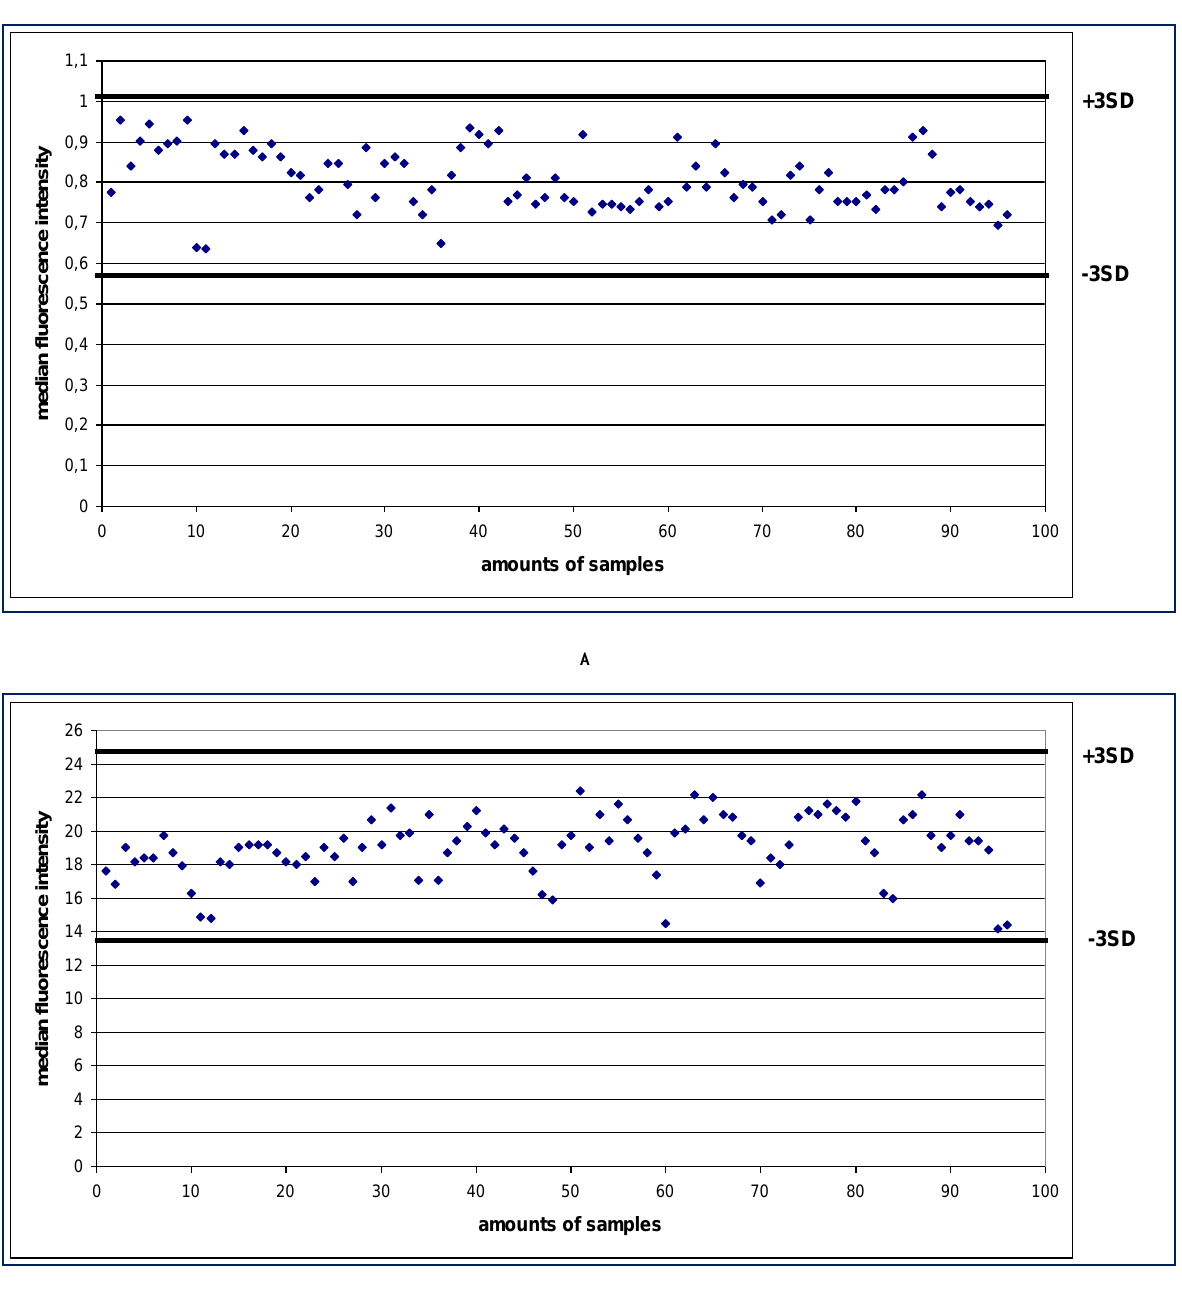
FIGURE 3. The accuracy of the automated Flow-GIFT was analyzed. Control serum (A) and a serum containing anti–HNA-1b (B) were prepared in each cavity of two 96-deep well plates and investigated. Then, 96 measured values (MFI) of each plate were calculated. All cavities with control serum and serum with anti–HNA-1b were negative and positive, respectively. The MFI values show a normal distribution (Kolmogorov Smirnov test) and are located within the range of mean ± 3